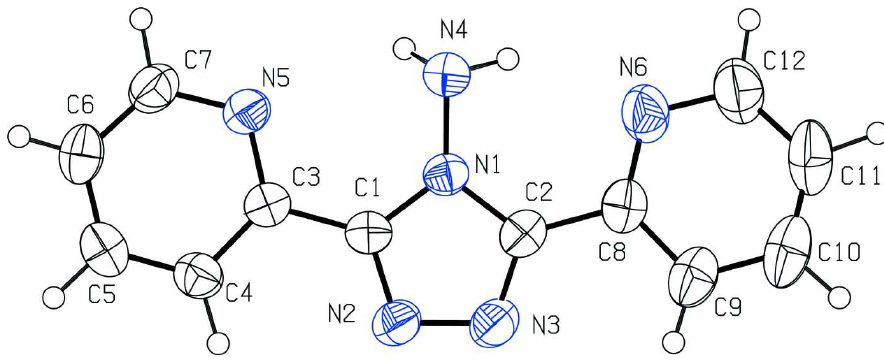
Figure 1 ORTEPII (Johnson, 1976) plot of the title compound. Displacement ellipsoids are drawn at the 50% level.